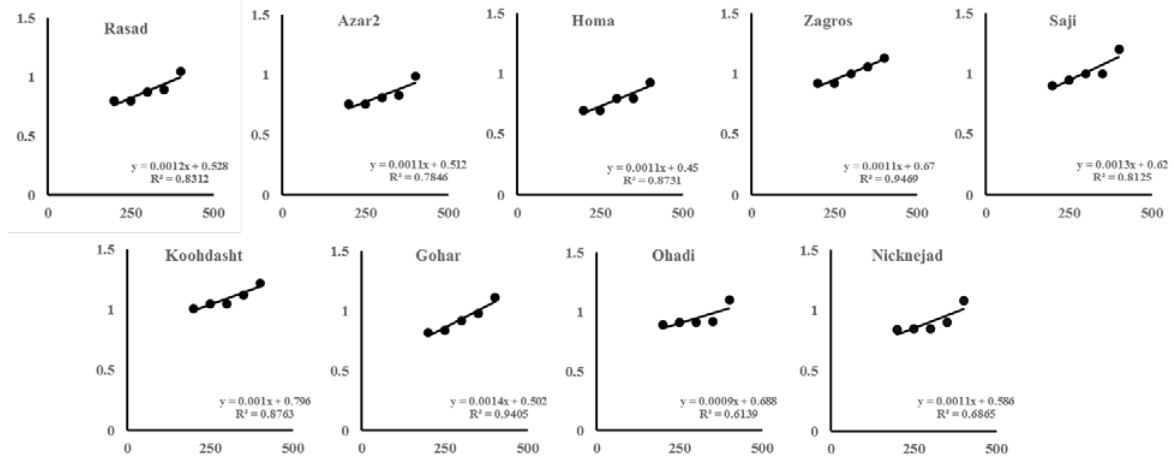
Fig. 2. Relations between the reciprocal of grain yield per plant and plant density. X axis: Plant population (plant m -2 ); Y axis: 1/w (1/g)